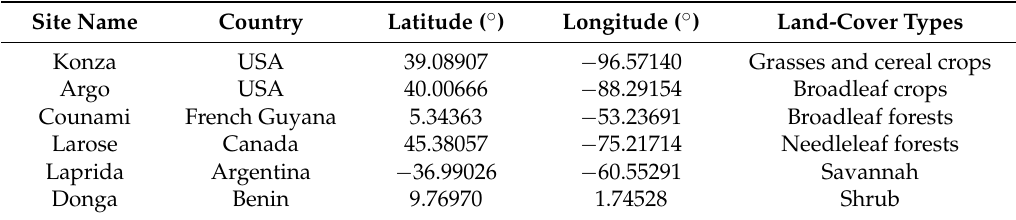
Table 2. Selected site